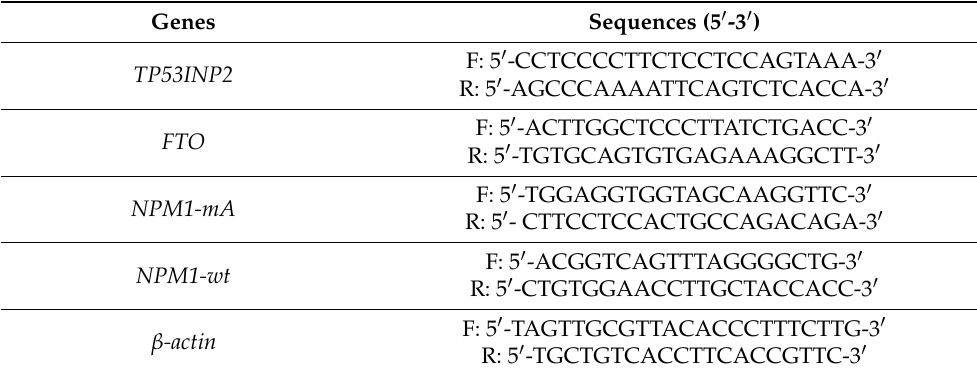
Table 2. The PCR primer sequences for each gene used in this